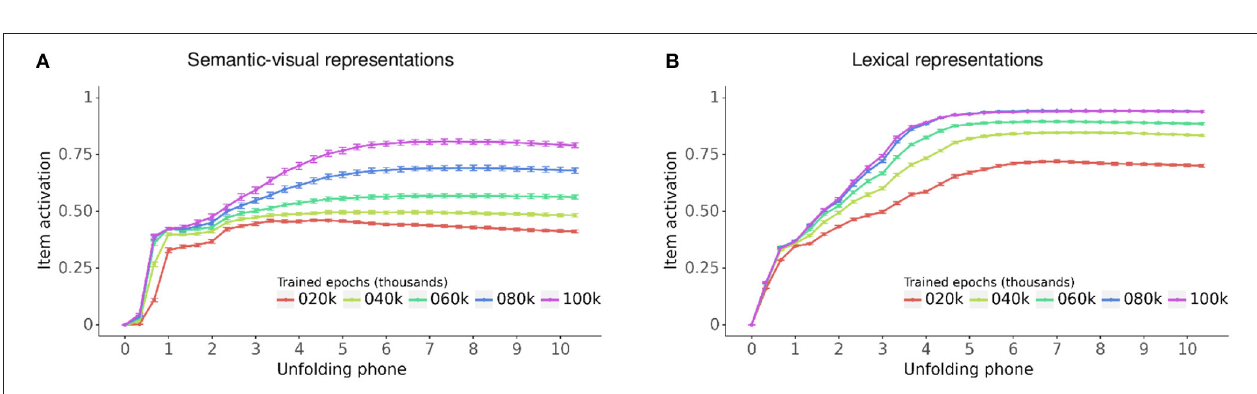
FIGURE 7 | Grand average of the activation time course for vocabulary items as their label unfolds, evaluated every 20,000 epochs during training for (A) semantic-visual representations and (B) lexical representations. Bars: 95 % confidence